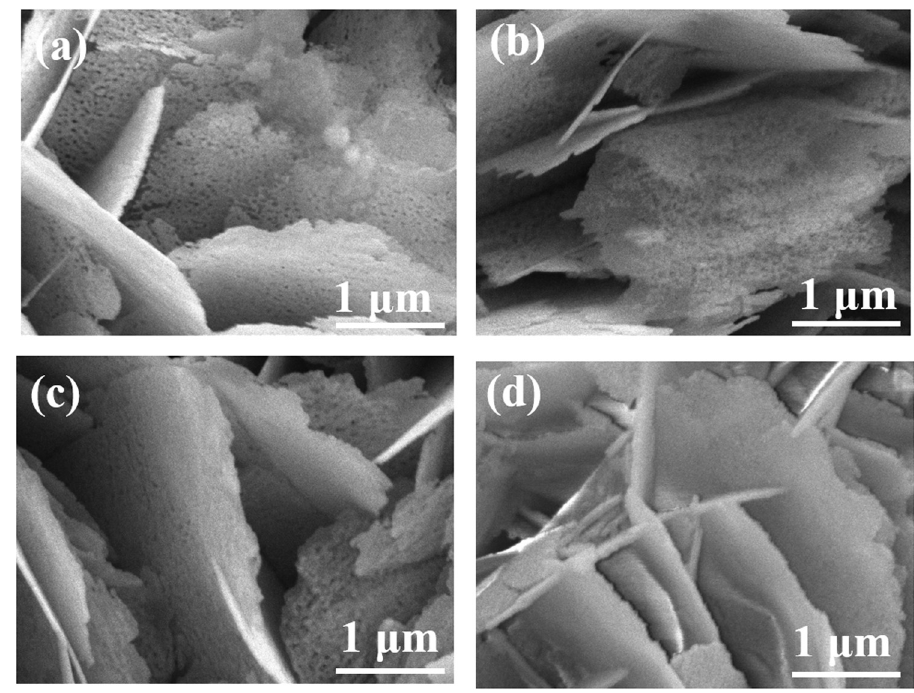
Figure 1: SEM images of various products: ( a ) ZnO template, ( b ) ZS - 1, ( c ) ZS - 2, and ( d ) ZS -